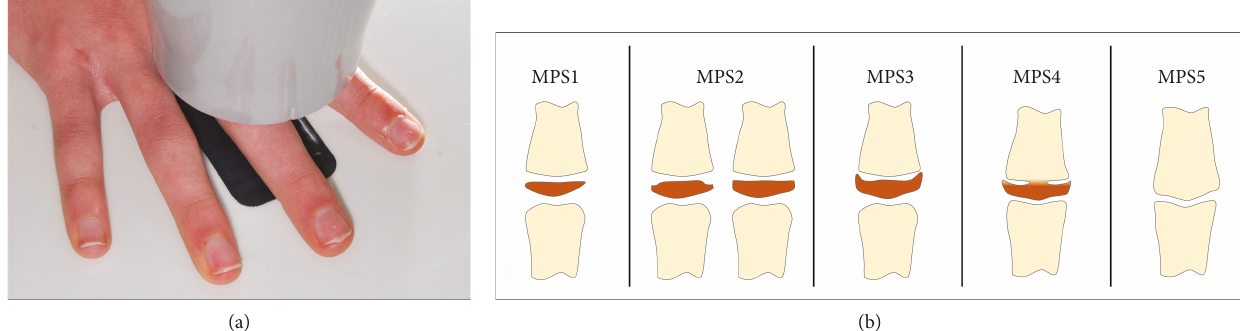
Figure 1: (a) Recording of the third fi nger middle phalanx fi lm through an intraoral X-ray unit. (b) The stages of the third fi nger middle phalanx maturation (MPM) method (reposted as MPS, see text for